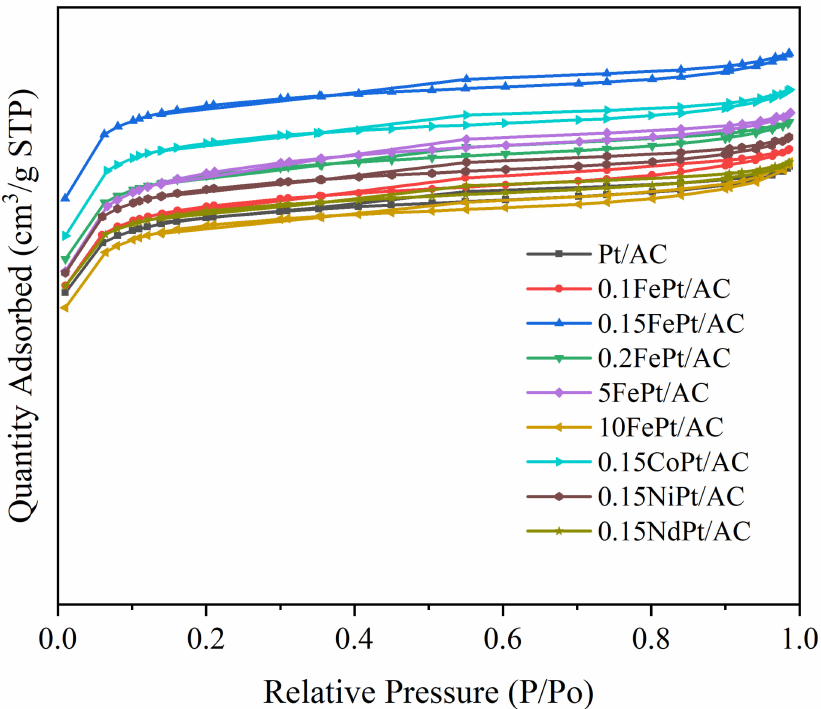
Figure 2. Nitrogen adsorption/desorption results of Pt-based